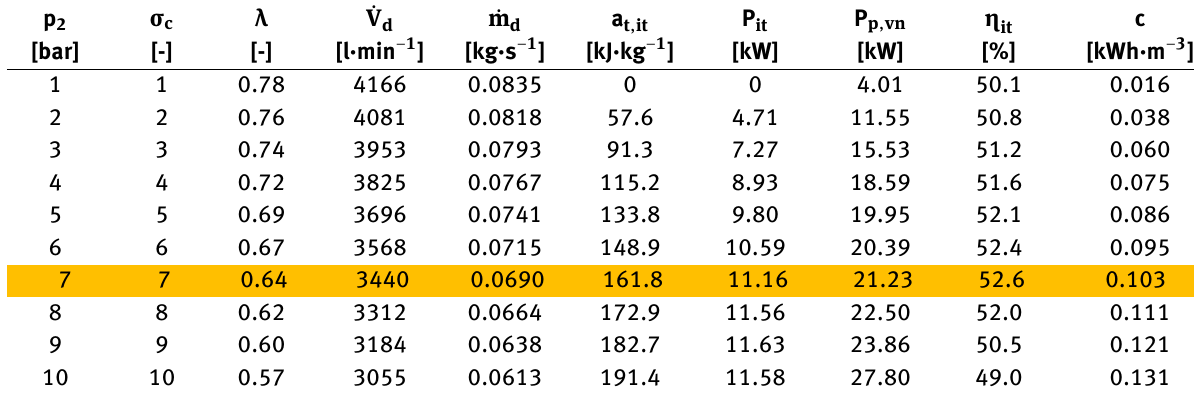
Table 2: Simulated screw compressor working process